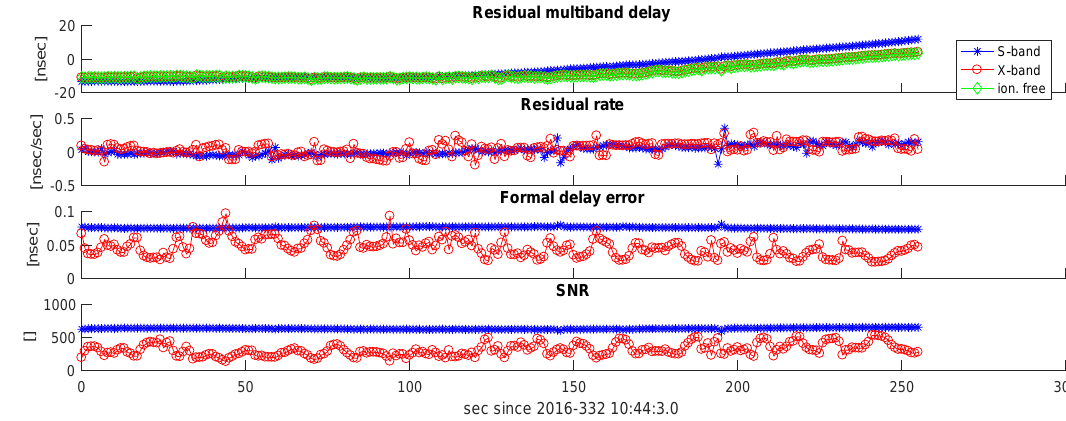
Figure 10. Fourfit results of Scan 169 in Experiment a332. Residual multi-band delays, residual delay rates, formal delay errors, and SNRs are plotted versus time indicated as seconds since scan